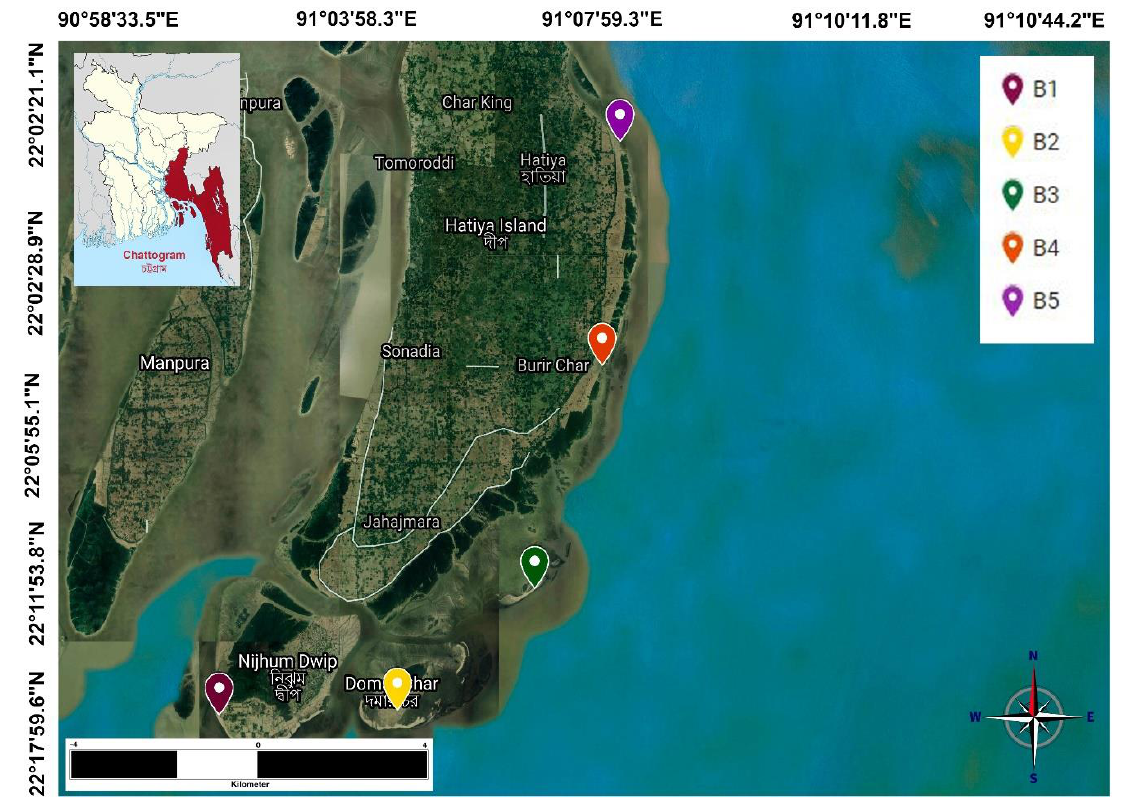
Figure 2. Location map of the sampling points (Google Map).